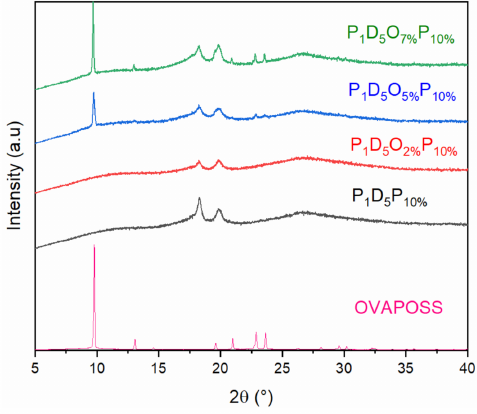
Figure 1. XRD curve of polymer